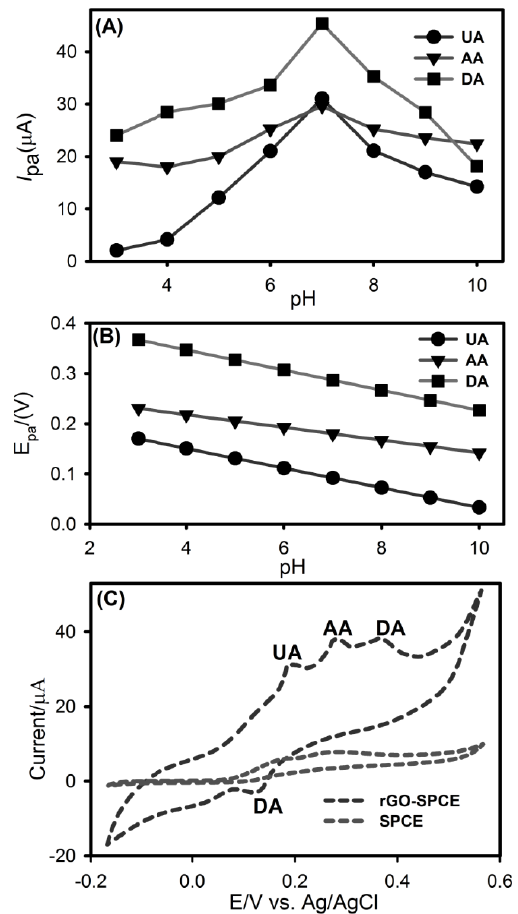
Figure 4. Effect of pH on the: ( A ) I pa ; and ( B ) E pa of UA (0.5 mM), AA (5.0 mM) and DA (0.5 mM) at rGO-SPCE. ( C ) Cyclic voltammograms of ternary mixture of UA (0.5 mM), AA (5.0 mM) and DA (0.5 mM) at SPCE and rGO-SPCE. Supporting electrolyte was BR buffer (pH 7.0), 50 mV·s −1 scan rate.